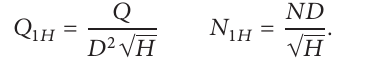
Figure 6: Cross-section of the computational domain.